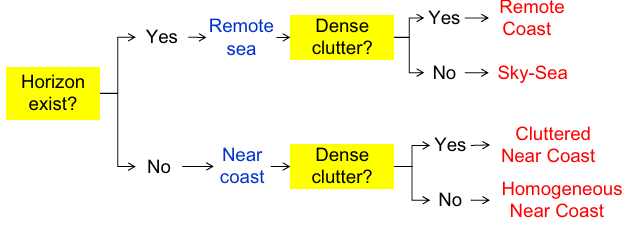
Figure 9. Proposed infrared scene classification method using the horizon and clutter density